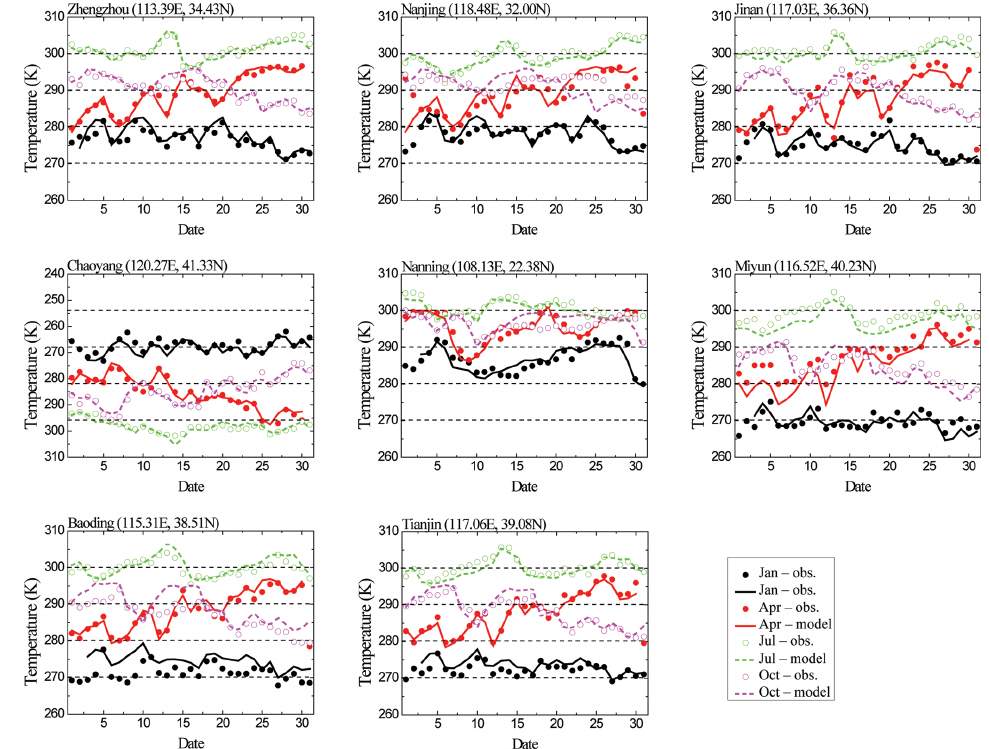
Figure A1. Observed and modeled daily average temperatures (K) in January, April, July, and October 2015.